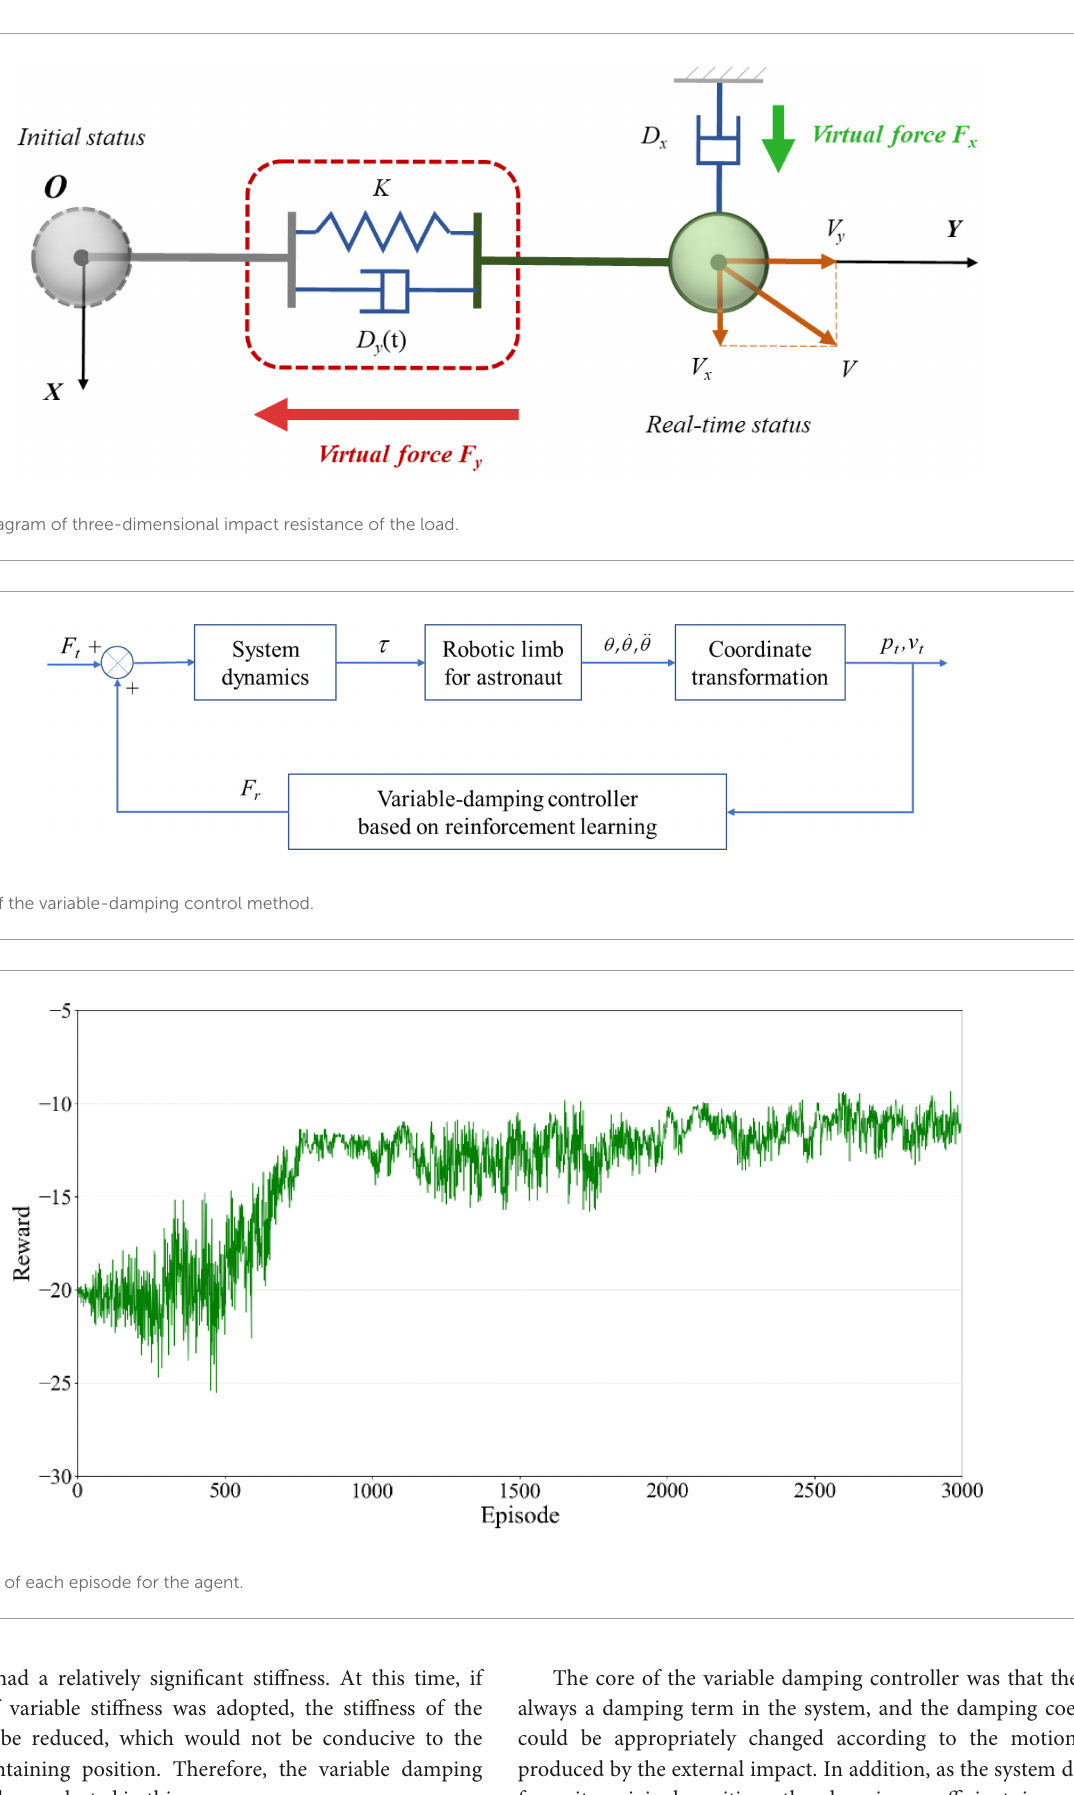
the astronaut had a relatively significant stiffness. At this time, if the method of variable stiffness was adopted, the stiffness of the system would be reduced, which would not be conducive to the astronaut maintaining position. Therefore, the variable damping control method was selected in this